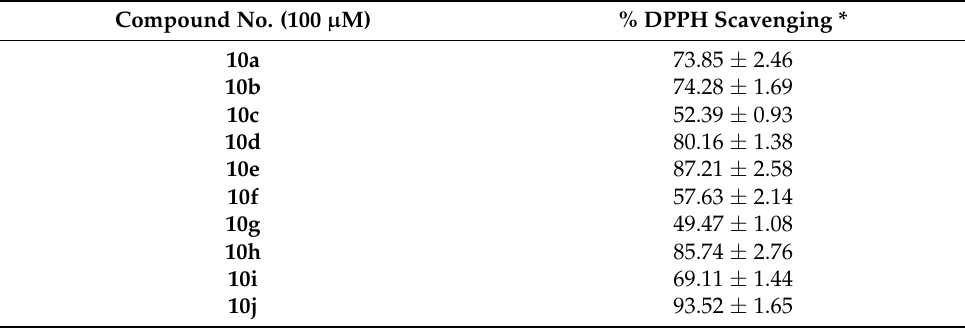
Table 2. Antioxidant activity of hybrids 10a–j using the DPPH method.